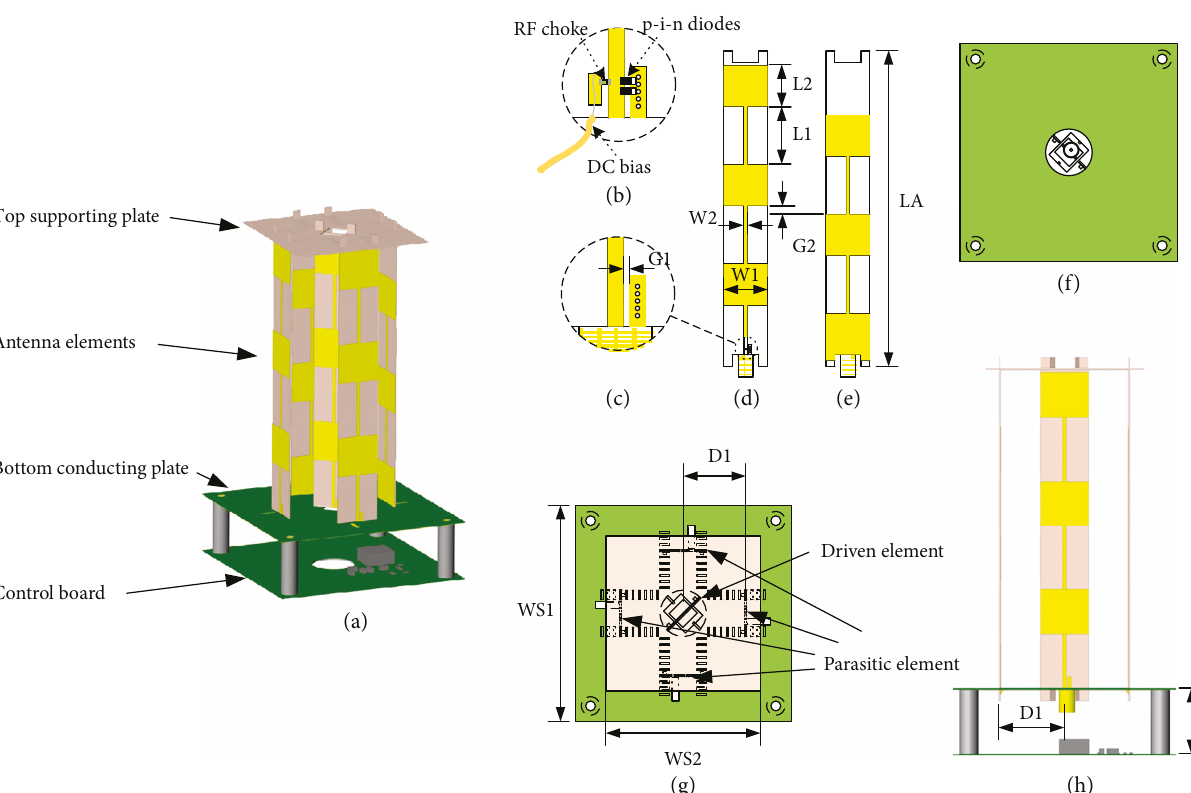
Figure 1: The details of the proposed antenna structure. (a) The structure of the proposed antenna. (b) The partial view of parasitic element arrays bias circuit with p-i-n diodes. (c) The partial view of the exciter probe circuit. (d) The top view of exciter. (e) The bottom view of exciter. (f) The bottom view of the proposed antenna. (g) The top view of the proposed antenna. (h) The side view of the proposed antenna. The dimension of the antenna is as follows: LA = 108mm , L1 = 20mm , L2 = 14 mm , W1 = 15mm , W2 = 1 1mm , G1 = 0 4mm , G2 = 3 mm , WS1 = 70mm , WS2 = 50mm , D1 = 20 mm , and D2 = 20 mm